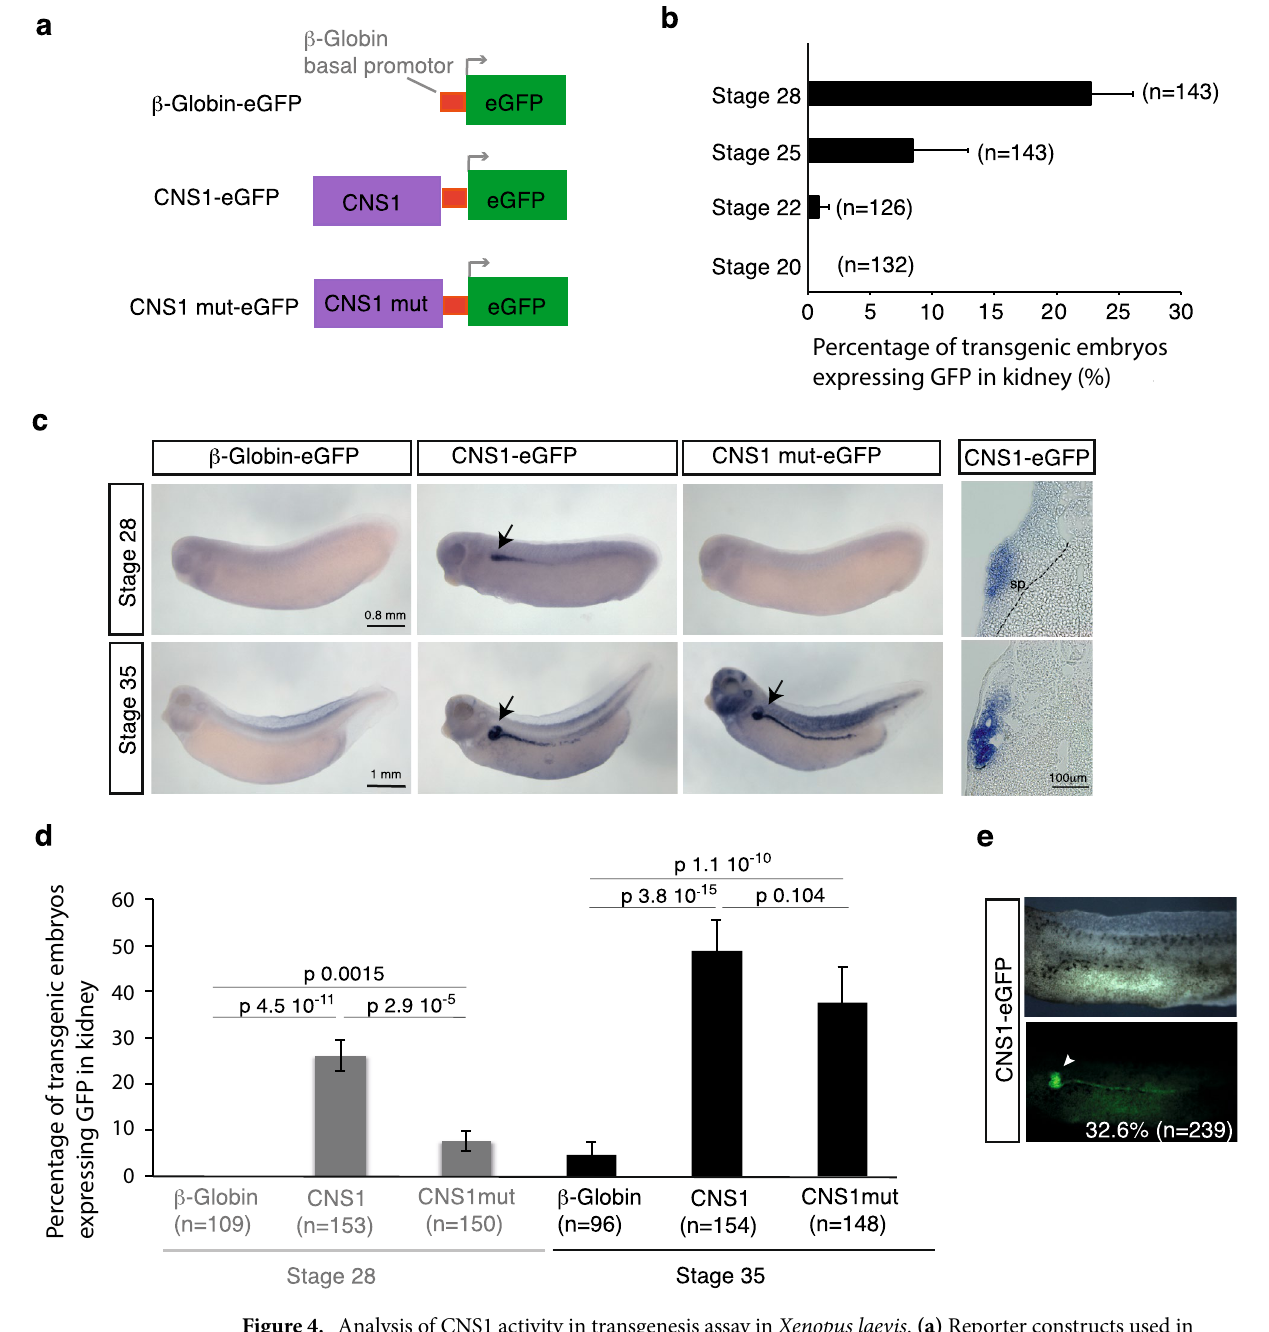
Figure 4. Analysis of CNS1 activity in transgenesis assay in Xenopus laevis . (a) Reporter constructs used in transgenesis. Wild type CNS1 or CNS1 mutated in the Pax8 binding site (CNS1 mut) was cloned upstream of the β-globin basal promoter and the eGFP reporter gene. (b) Percentage of F0 CNS1-eGFP transgenic embryos generated by the I-Sce I meganuclease method showing GFP expression detected by in situ hybridization in the developing pronephros at stages 20, 22, 25 and 28. Results corresponding to three independent experiments. (c) GFP expression detected by in situ hybridization in representative F0 transgenic embryos at stages 28 and 35 generated with reporter constructs as indicated. Transverse cryostat section (16 μm) of CNS1-eGFP transgenic embryos showing GFP reporter gene expression at the level of the proximal part of the pronephros are shown on the right. At stage 28, the dotted line delineates the mesoderm-endoderm frontier. sp splanchnic mesoderm. (d) Percentage of F0 transgenic embryos generated with the indicated reporter constructs expressing GFP in pronephros at stages 28 and 35. Results from three independents experiments. Statistical significance was determined using Fisher’s exact test. P-values are annotated on the figure. (e) Representative stage 40 F0 transgenic tadpole obtained by the REMI method with the CNS1-eGFP construct. Arrowhead indicates the fluorescent pronephros. In (b,d,e) , n indicates the total number of analysed